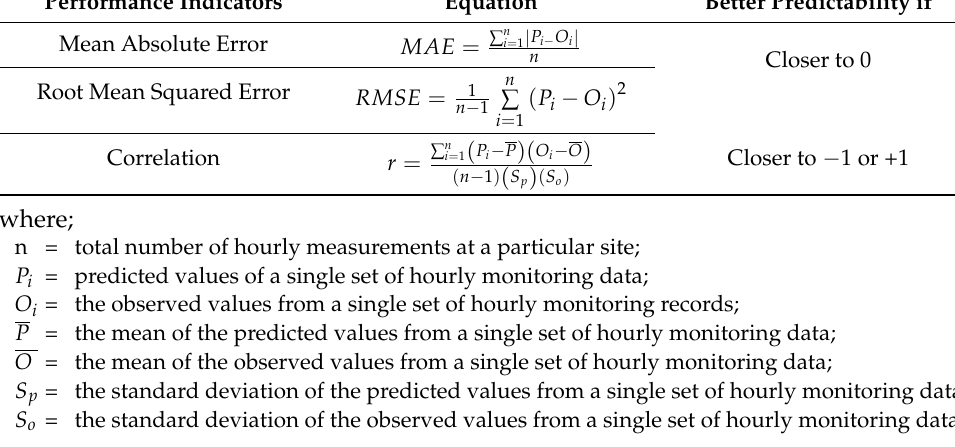
Table 3. Performance indicators. Performance